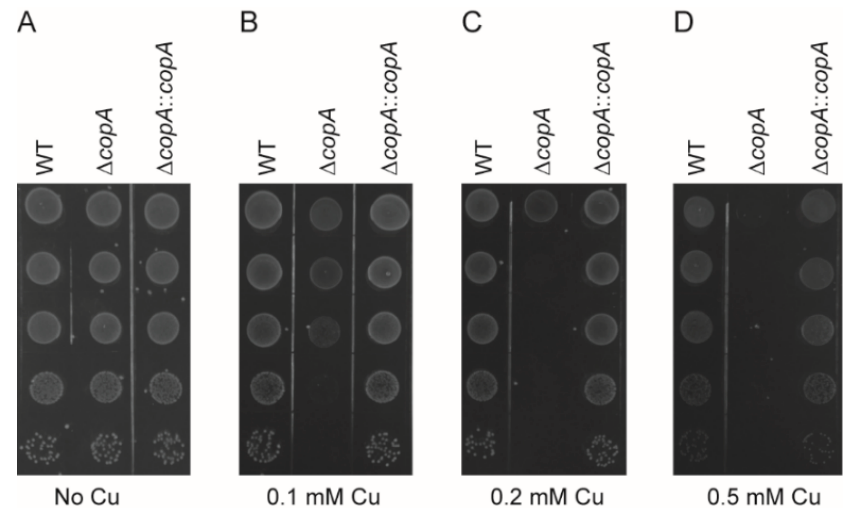
Figure 4. CopA is required for S. suis resistance to copper toxicity in liquid medium. Growth curves of the wildtype (WT), Δ copA , and Δ copA :: copA strains in the absence ( A ) and presence of 0.05 mM ( B ), 0.1 mM ( C ), 0.2 mM ( D ), 0.5 mM ( E ), and 1 mM ( F ) Cu. The data in the graphs are the means and SD from three wells.